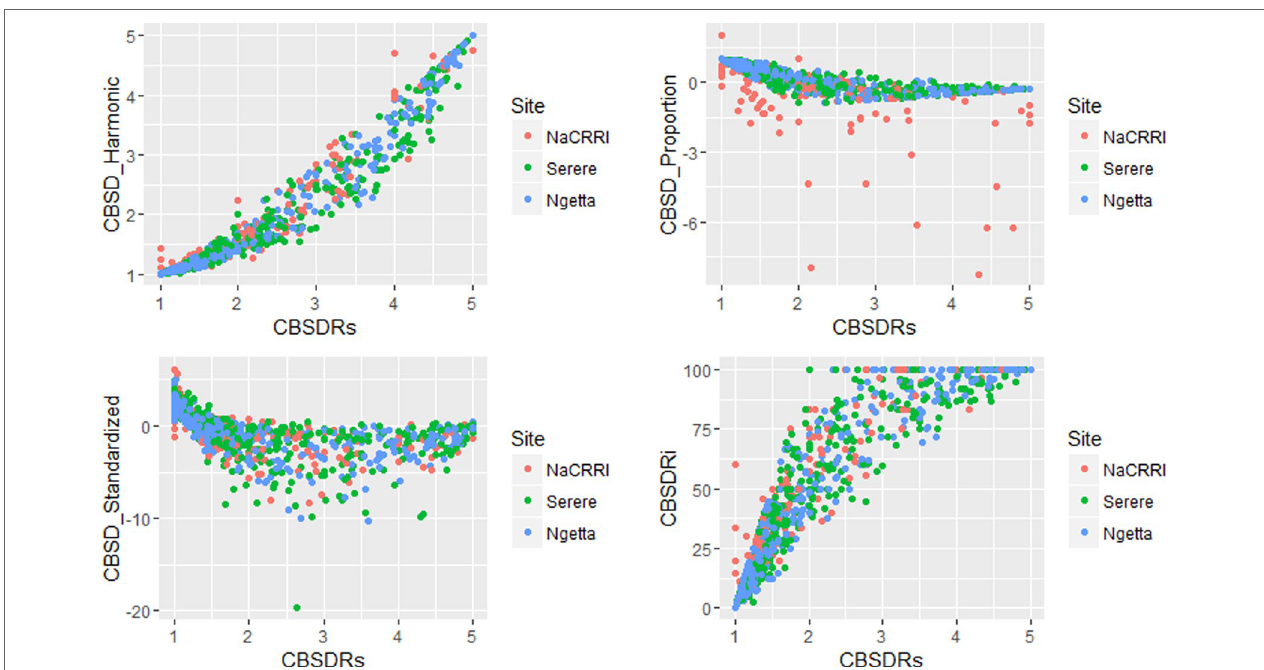
FiGURe 3 | Correlations amongst the CBSD root necrosis assessment traits across three sites: Namulonge (central Uganda), Ngetta (northern Uganda) and Serere (eastern Uganda). CBSDRi, cassava brown streak disease root incidence; CBSDRs, cassava brown streak disease root severity; CBSD-Harmonic, cassava brown streak disease root severity computed as harmonic mean; CBSD-proportion, proportion-based root necrosis index; CBSD-standardized, standardized root necrosis